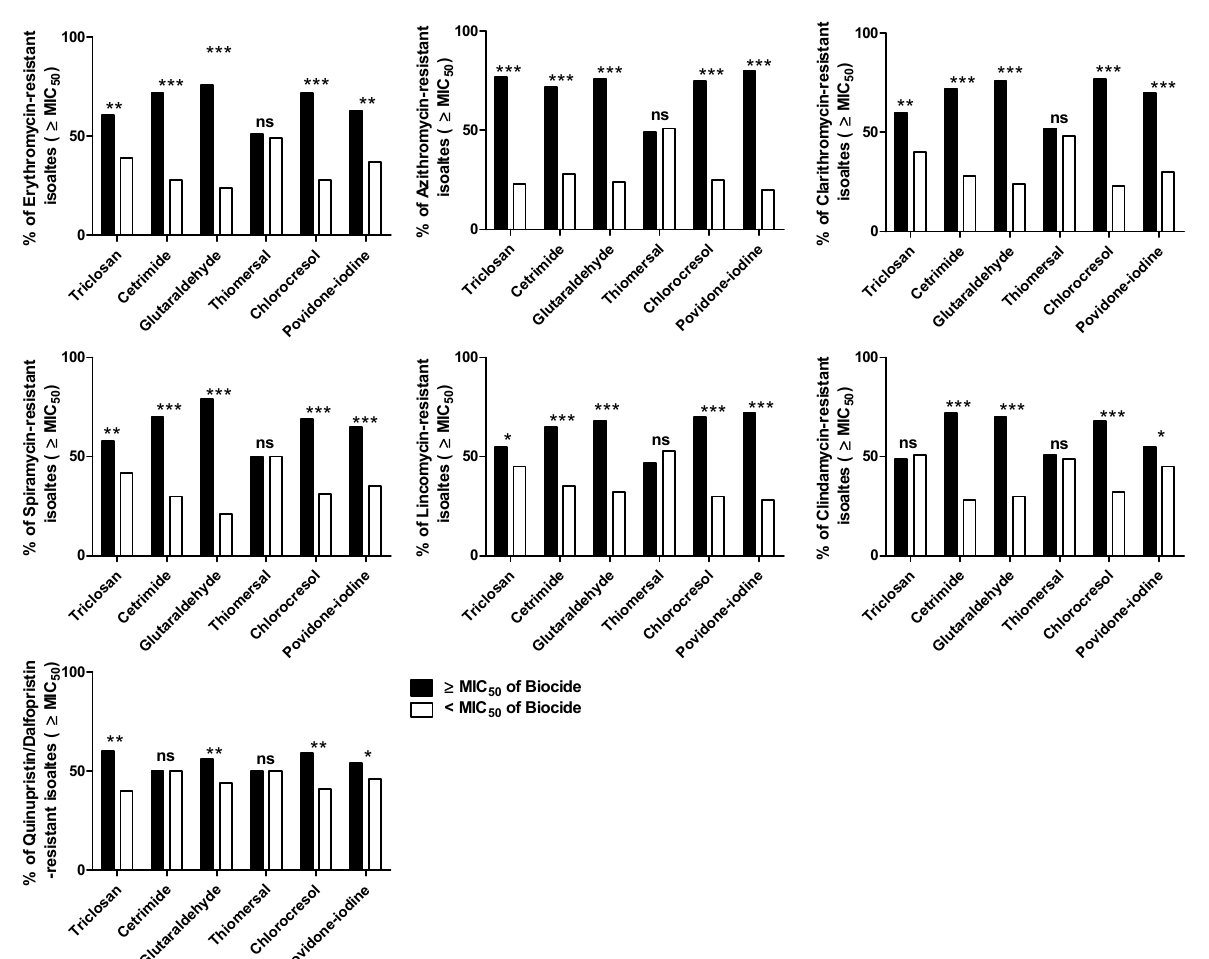
Figure 6. The percentages of reduced susceptible isolates to biocides (MIC ≥ MIC 50 ) in the antibiotics- resistant isolates with MIC ≥ MIC 50 . The chi-square test was used to compare the difference in the percentage of antibiotic-resistant isolates with MIC above or below the MIC 50 of tested biocides. It was observed that in the antibiotic-resistant isolates, the percentages of reduced susceptible isolates to all biocides except thiomersal were increased significantly. ns: p > 0.05, *: p ≤ 0.05, **: p ≤ 0.01, ***: p ≤